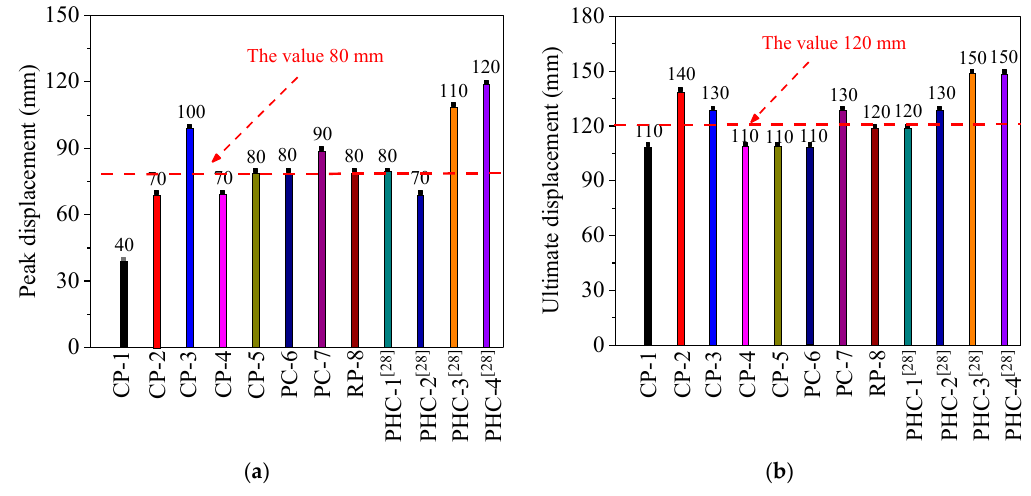
Figure 18. ( a ) Peak and ( b ) ultimate displacements of the piles obtained from the backbone curves.